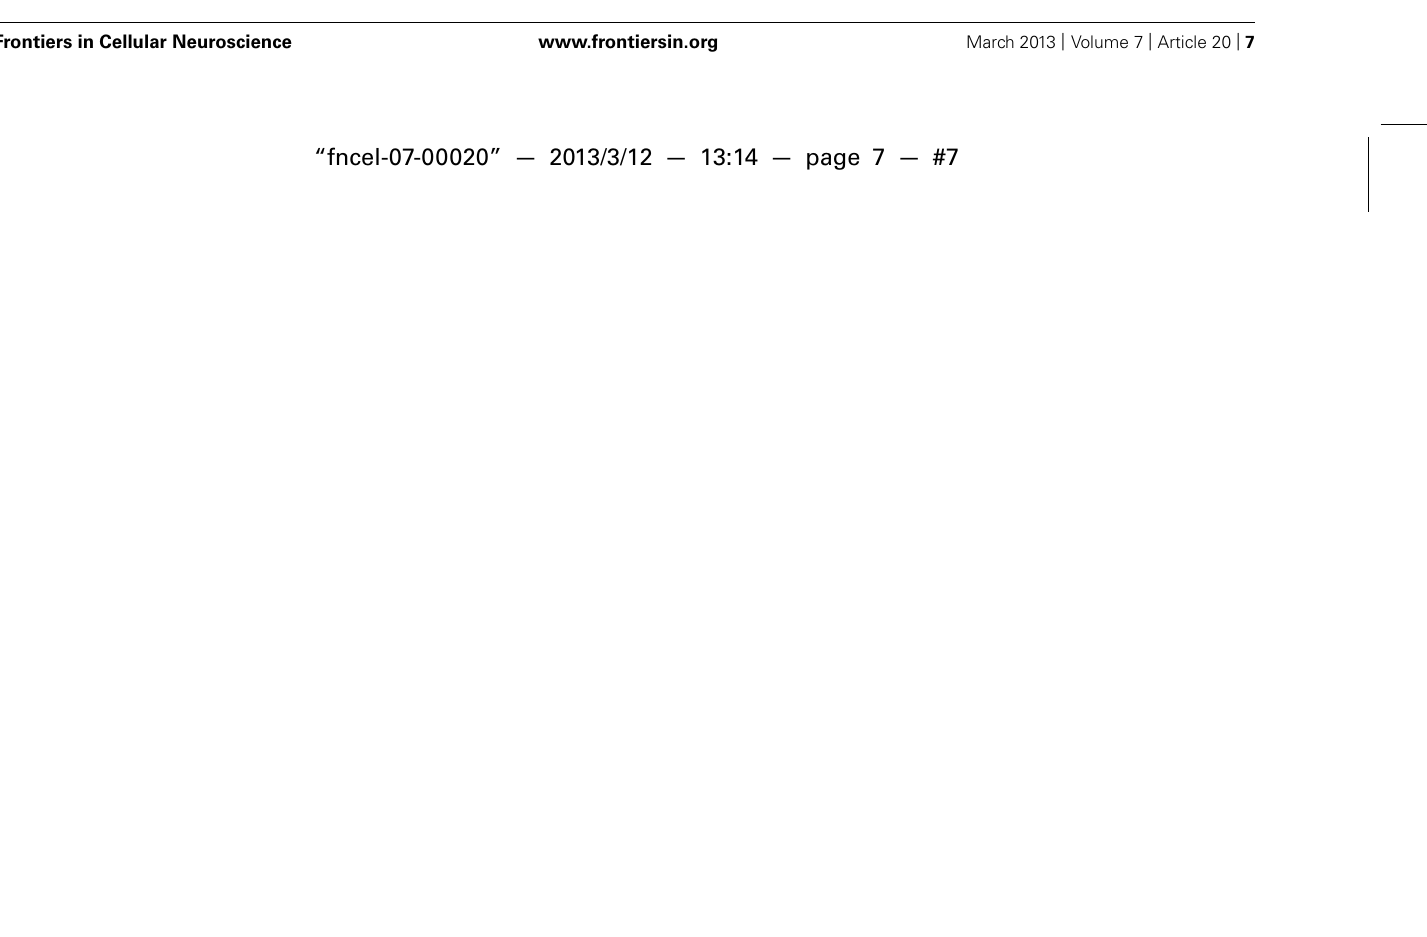
are shown in the insets. On the I–V curve for the currents via GABA(A) channels, the reversal potential reflects the GABA driving force value. On the I–V curve for the currents via NMDA channels, the reversal potential reflects the resting membrane potential. (B,D) Pooled data on resting membrane potential ( E m ), the reversal potential of GABA-activated currents ( E GABA , calculated for each cell as mean E m + DF GABA ) and DF GABA in P2 (B) and P5 (D) intact hippocampi. Each open circle corresponds to an individual neuron, closed circles show mean values ±